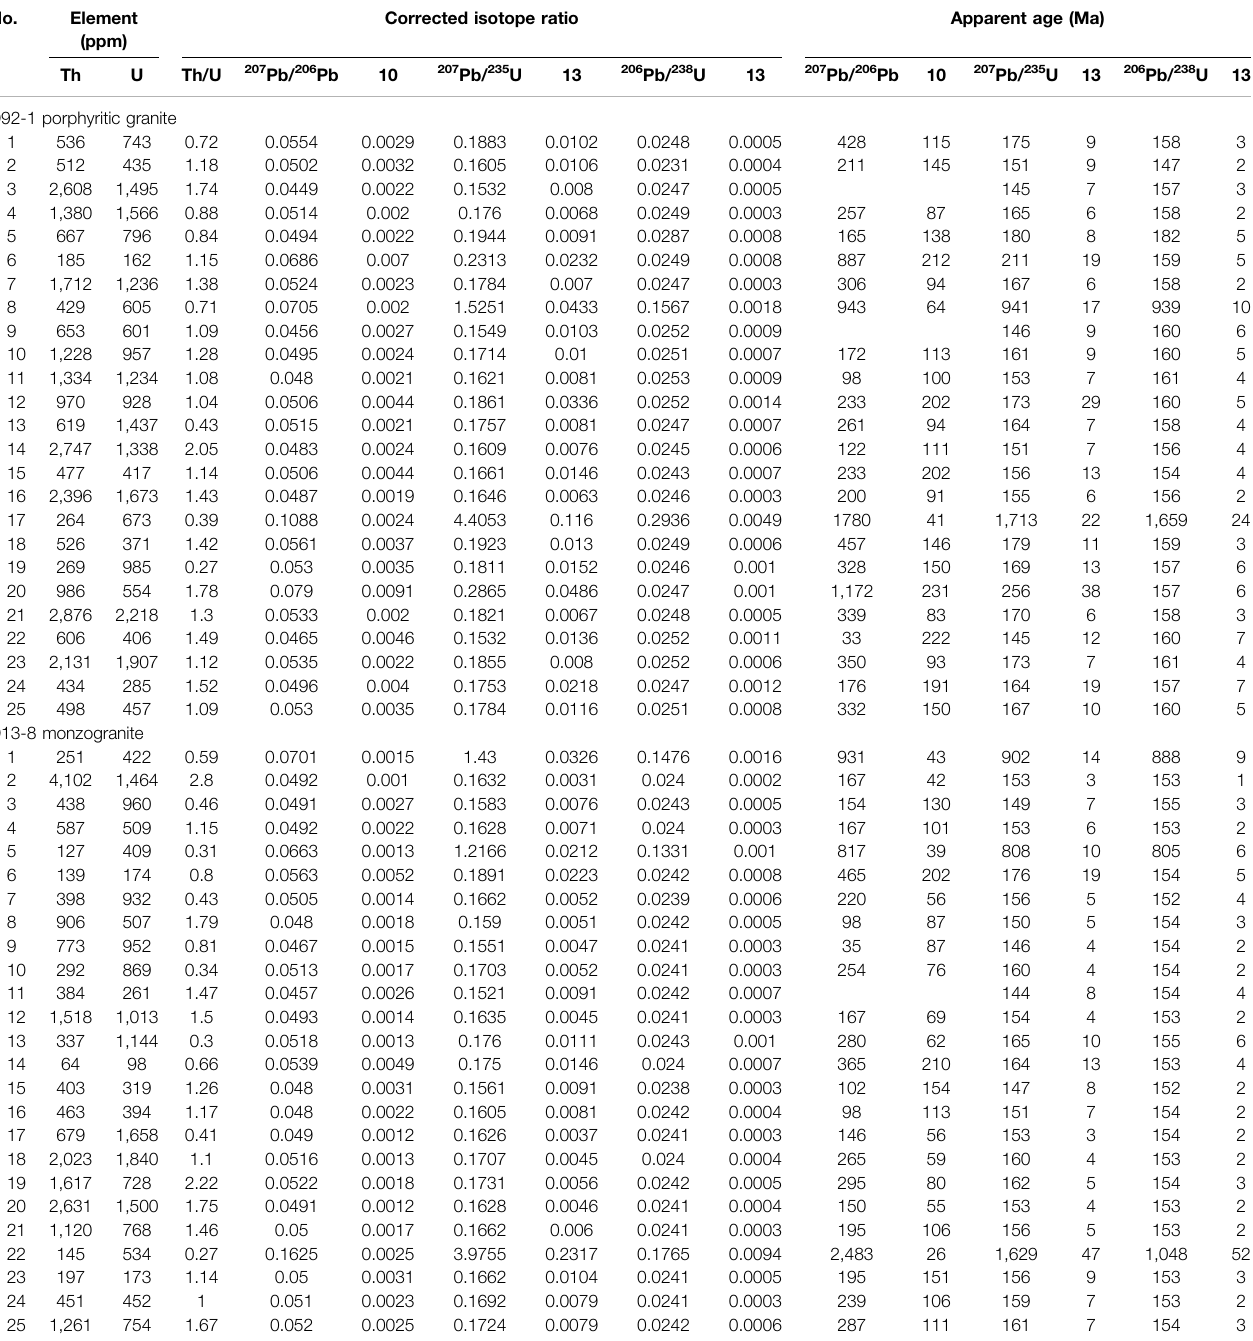
Corrected isotope